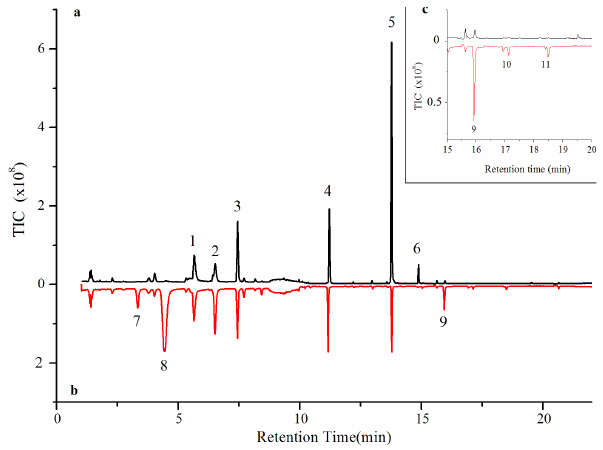
Fig. 2. Total ion chromatogram (TIC) of (a) VOCs emitted by grass clippings/headspace and (b) as a result of the ozonolysis of grass clippings/headspace. (a) GLVs emitted (black trace) show a complex mixture of volatile compounds with (3) 2-pentanone, (4) 1-penten-3-ol, (5) cis- 3-hexenyl acetate and (6) cis -3-hexenol predominating. Other emitted VOCs include (1) methanol and (2) ethanol. Immediately post-ozonolysis (b) (red trace, 800ppb ozone), (5) cis- hexenyl acetate and (6) cis -hexenol signal dropped significantly indicating their reactivity with ozone, while chromato- graphic peaks from (7) propanal, (8) propenal, (9) acetic acid, (10) propanoic acid and (11) propenoic acid appeared, apparent products of cis- 3-hexenyl acetate and/or cis -3-hexenol ozonolysis.